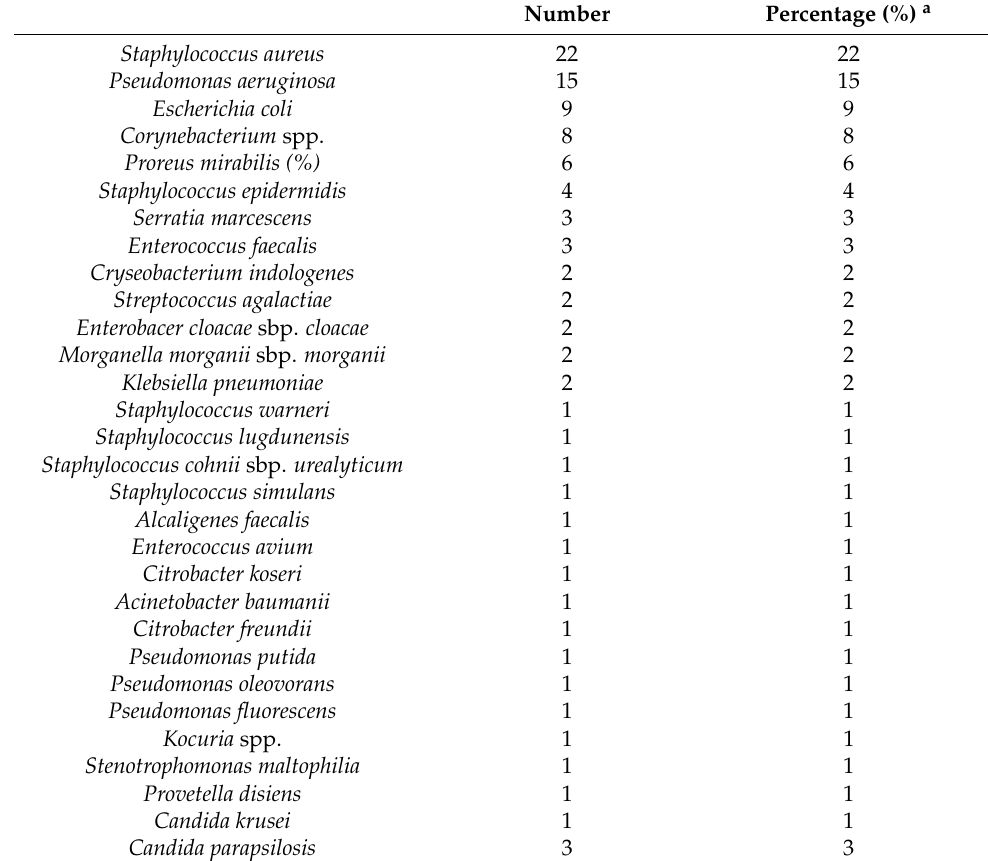
Table 5. DFUs’ bacterial epidemiologic